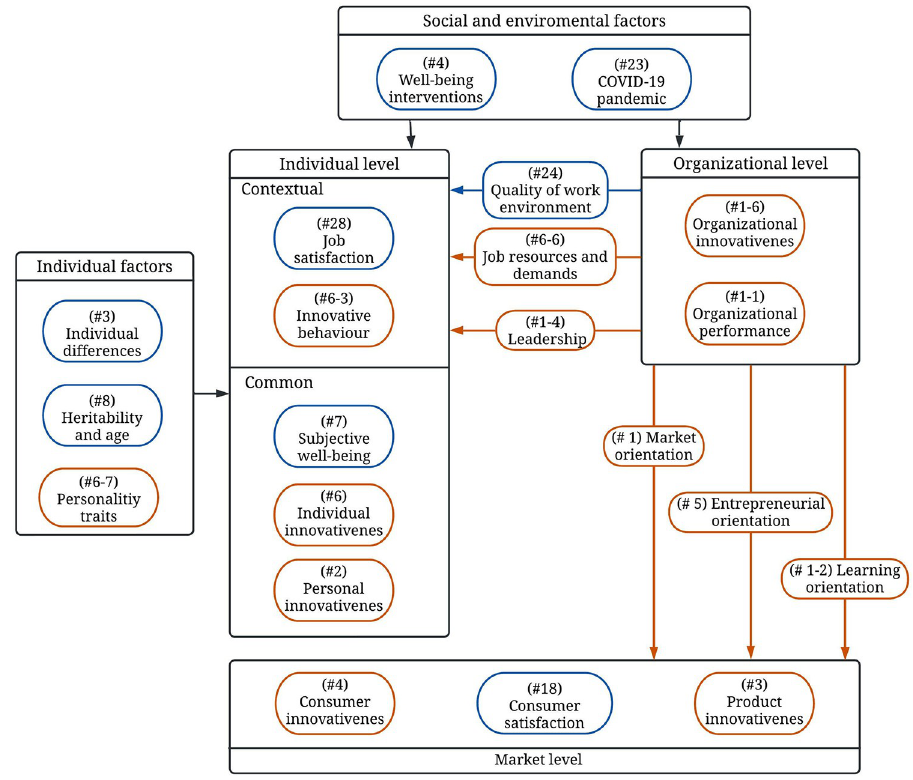
Fig 4. Multi-level conceptual framework depicting the relationship between employee well-being and innovativeness and other related constructs.